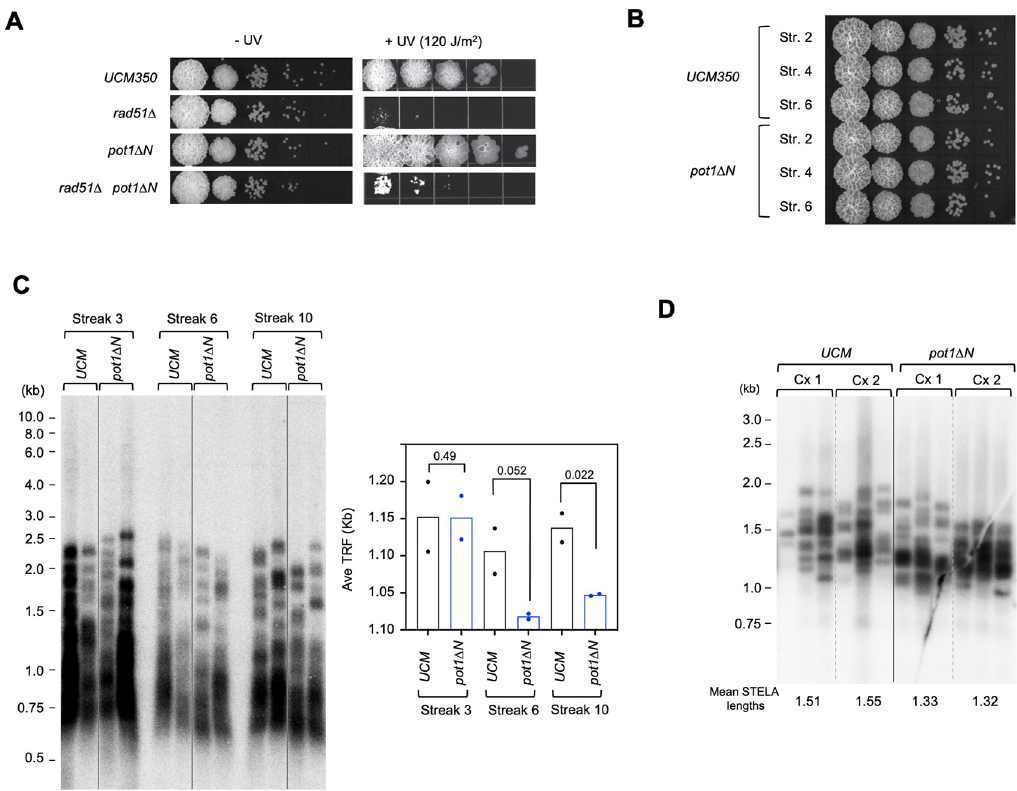
Fig 3. Pot1 N-terminal deletion impairs telomere maintenance. A. Serial dilutions of the indicated U . maydis strains were directly spotted onto a YPD plate or first subjected to UV irradiation prior to spotting. The plates were incubated for 2 days (-UV) or 3 days (+UV) and the results photographed. B. Serial dilutions of cultures of UCM350 and pot1 Δ N that had been passaged for the indicated numbers of streaks were spotted onto a YPD plate and incubated for 2 days. C. Chromosomal DNAs from two independently propagated clonal cultures of UCM350 and pot1 Δ N were subjected to TRF Southern analysis at the indicated passages (i.e., Streak 3, 6 and 10). Mean TRF lengths from the pairs of assays were calculated and plotted at the bottom. P-values were calculated using two-tailed Student’s t tests and displayed. D. Chromosomal DNAs from two independently propagated clonal cultures of UCM350 and pot1 Δ N strains were subjected to STELA analysis at Streak 10. Mean STELA lengths were calculated from 3 independent assays of each DNA sample and shown at the bottom.